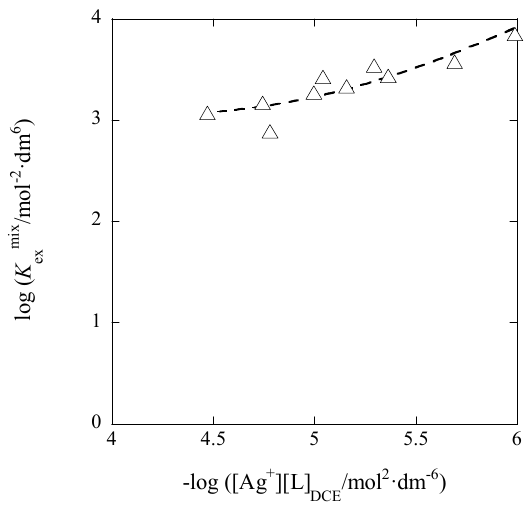
Figure 3. A plot of log K exmix vs. − log([Ag + ][L] DCE ) for the AgClO 4 extraction with B18C6 (= L) into DCE. The regression line was log K exmix = log{9.7 × 10 2 + (7.4 × 10 − 3 )/([Ag + ][L] DCE )} at r = 0.891.